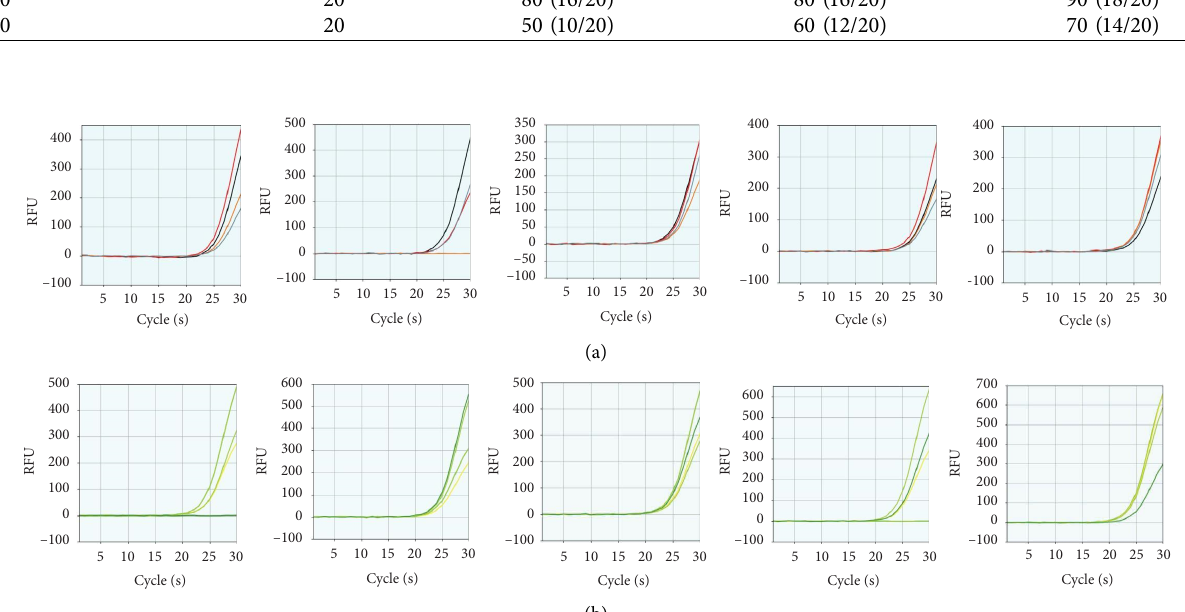
Figure 2: PCR amplifcation curve of SARS-CoV-2 LoD sample by spiking the SARS-CoV-2 virus into the negative matrix to 250 copies/ mL. (a) Te ORF1ab amplifcation curve for 20 replicates. (b) N gene amplifcation curve for 20